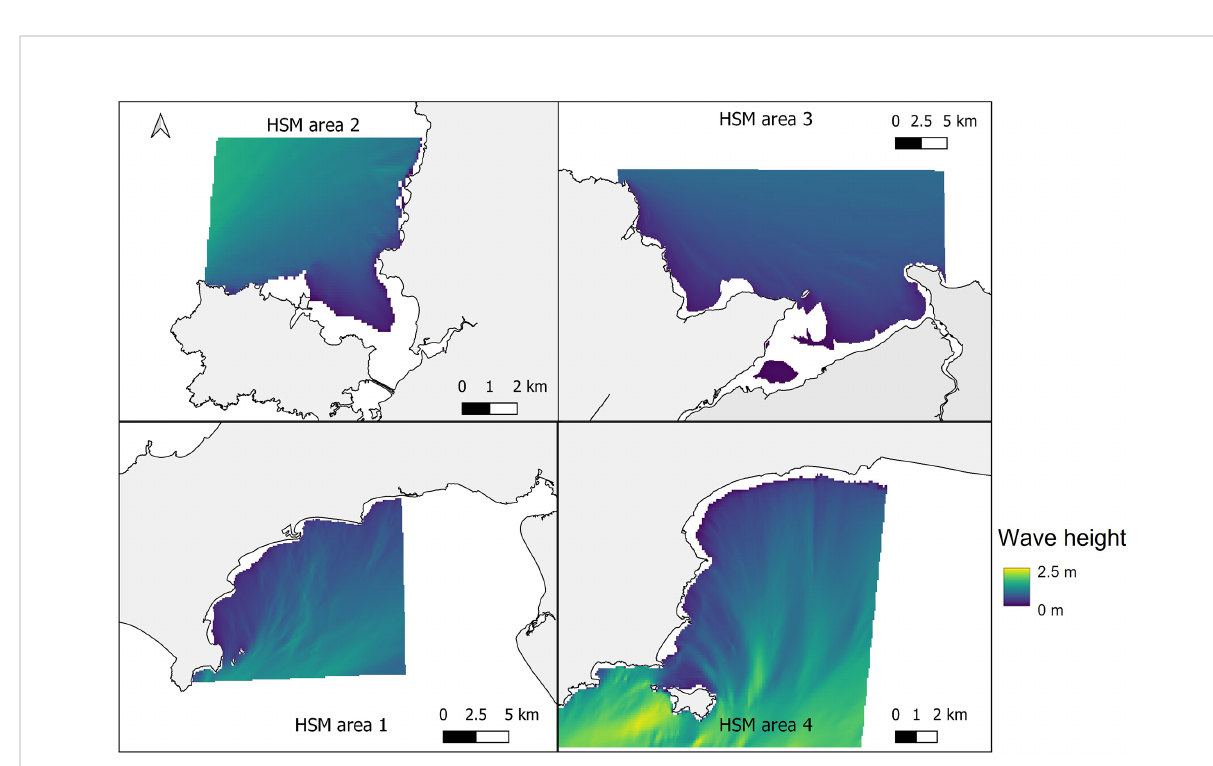
FIGURE 4 Mean signi fi cant wave height from across the fi ve January model runs (2015-2019) at the four selected sites. Top left – West Anglesey (area 2), top right – East Anglesey (area 3), bottom left – Llyn Peninsula (area 1), bottom right – Pembrokeshire (area